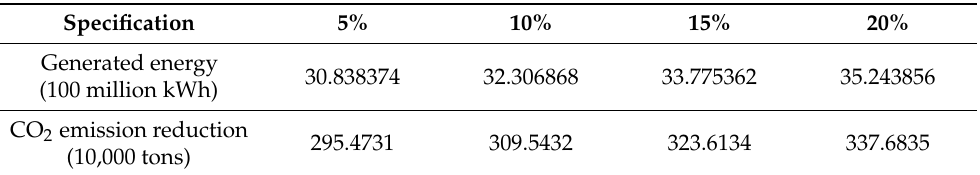
Table 2. Estimates of the reduction in CO 2 emissions as a result of increasing energy production from hydropower in